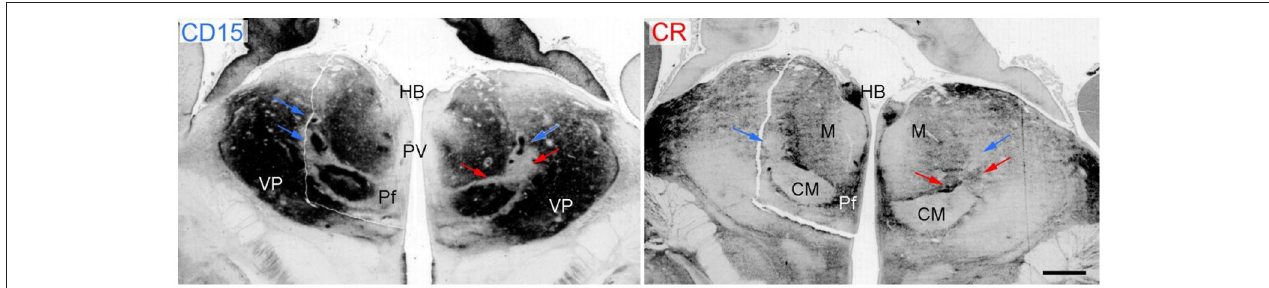
FIGURE 5 | Coronal sections through the thalamus of a fetal human brain at 17 weeks of pregnancy. The immunoreactivity against the cell-surface epitope CD15 (left) and calbindin (right) shows the main thalamic nuclei separated by the intralaminar formation that is CD15 negativ (red arrows) except the associated nuclei (Ncl. centrum medianum CM and Ncl. centralis lateralis, blue arrows) but calbindin positive. Scale bar 1mm. HB, habenula; Pf, parafascicular nucleus; PV, periventricular region; VP, ventroposterior complex.